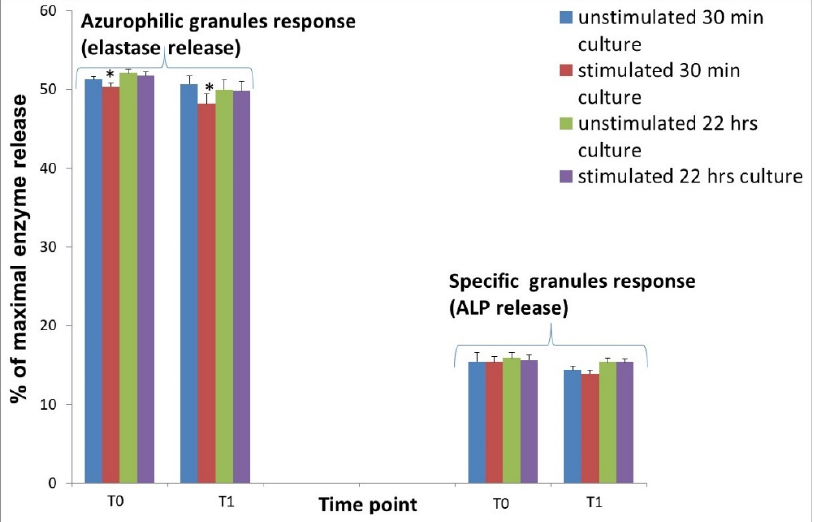
Figure 4. Release of elastase and alkaline phosphatase (ALP) from neutrophils isolated from sheep 7 days before implantation (T0) and 1 h (T1) after Ti implant insertion into the tibia. Cultures of isolated neutrophils were left without stimulation (unstimulated) or stimulated with 40 μ g ANE for 30 min and for 22 h. Data represents the mean ± SE of 8 sheep with duplicate measurements. There are significant differences between mean values marked with * ( p < 0.05).